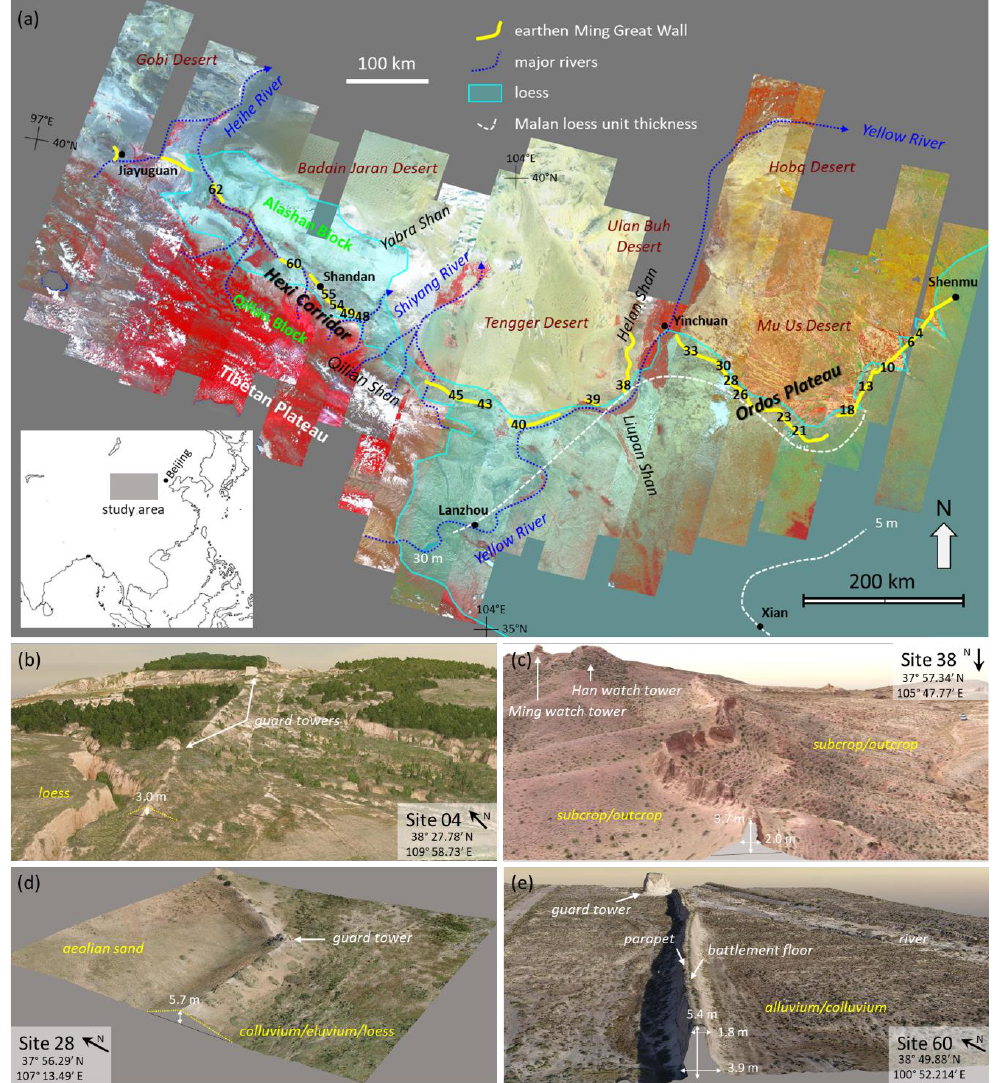
Figure 1. ( a ) Satellite ASTER false-color mosaic (Band 3: red; Band 2: green; Band 1: blue) spanning the Ordos Plateau and Hexi Corridor from Shenmu in the east to Jiayuguan in the west and including approximately 1200 km of the earthen Ming Great Wall (yellow line). The geological blocks, mountains, deserts, rivers, loess extent, thickness of the late-Pleistocene Malan loess unit [8], towns/cities, and field sample sites are also shown. ( b – e ) Oblique views of rendered digital elevation models of selected field sites generated from drone natural color imagery. The nature of local surface materials is indicated as well as several features of the